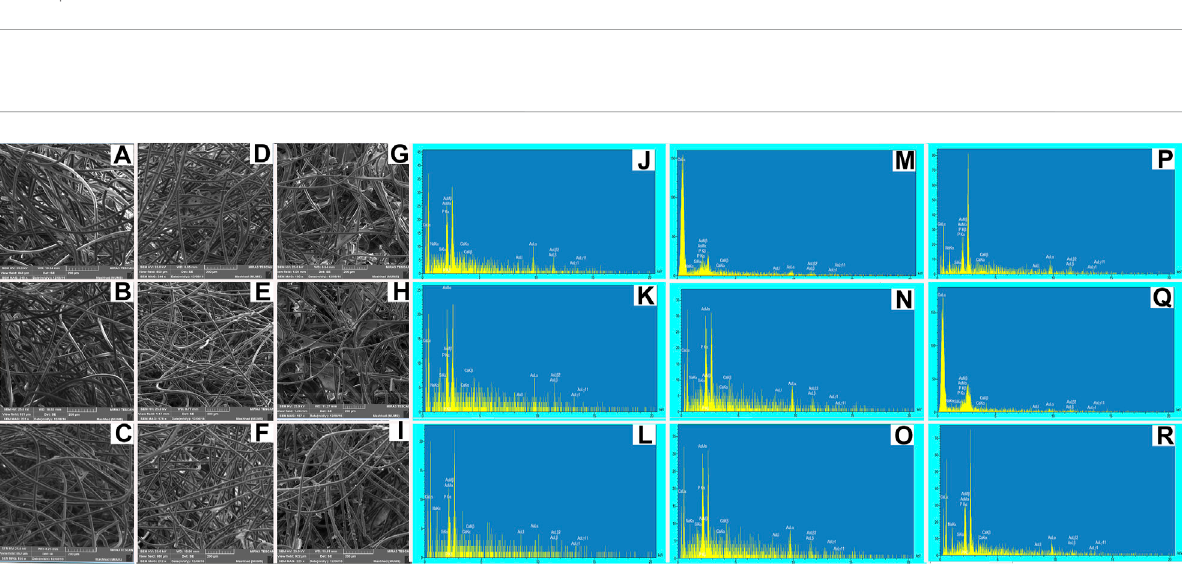
FIGURE 2 Framestructure,SEMmicrographsandEDSspectraofBG-Collagen/PGAscaffolds:PhysicalpictureofBG-collagen/PGAscaffold (A) .Sectionof (B,E,H) 5S5/PGA and collagen 0/100, (C,F,I) 45S5/PGA and collagen 40/60, (D,G,J) 45S5/PGA and collagen 70/30. The dispersion of BG nanoparticles in PGA matrix can be seen (C,F,D,G) .